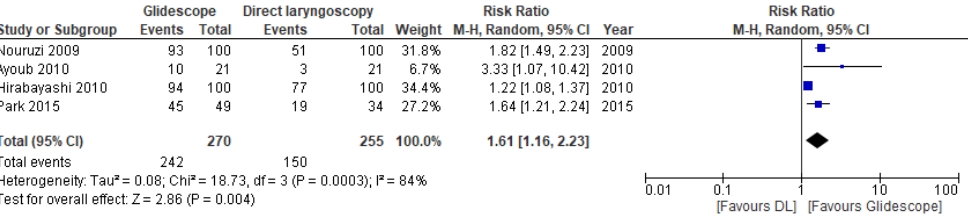
Figure 5. Risk ratios (RR) of successful first-attempt intubation in clinical trials comparing Glidescope ® videolaryngoscopy to direct laryngoscopy. The pooled estimate (rhombus) was derived using the DerSimonian and Laird random effects method. The squares depict individual study point estimates of the RR. Horizontal lines display the 95% CI of the point estimate. The vertical line represents an RR of 1.00 indicating no difference between Glidescope ® videolaryngoscopy and direct laryngoscopy; (DL = direct laryngoscopy). Nouruzi, 2009 [38]; Ayoub, 2010 [36]; Hirabayashi, 2010 [37]; Park, 2015 [39].